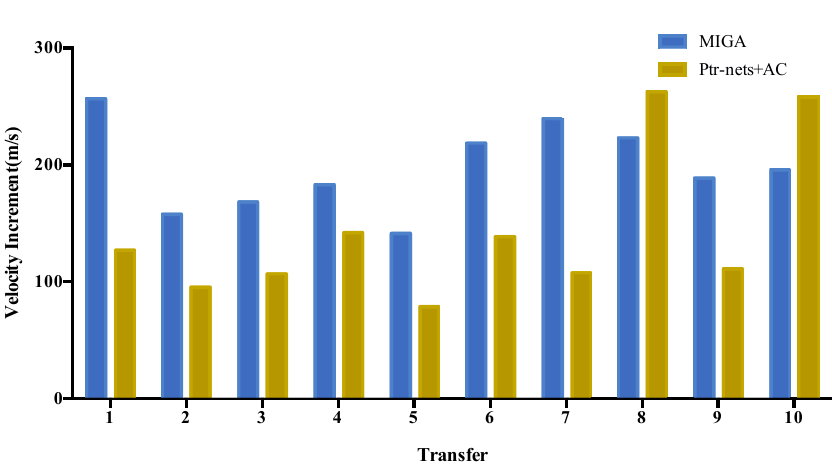
Figure 12. Variation of the 10 transfer velocity increments for the No. 2 debris removal sequence optimized by the MIGA and Ptr-nets+AC